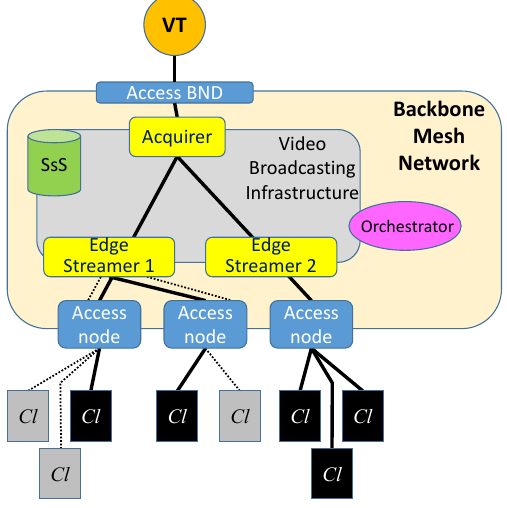
Figure 3. Video monitoring platform architecture. VT: video transmitter.